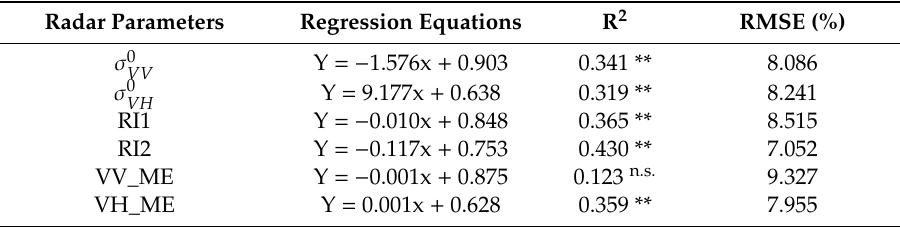
Table 3. The regression relationships between CRC and radar parameters. Radar